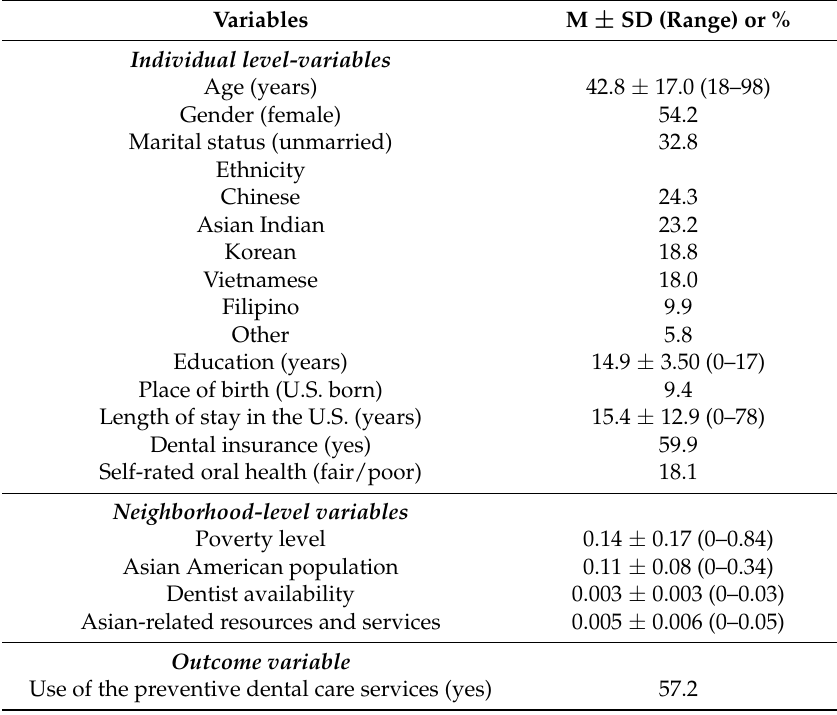
Table 1. Descriptive characteristics of the sample ( n =